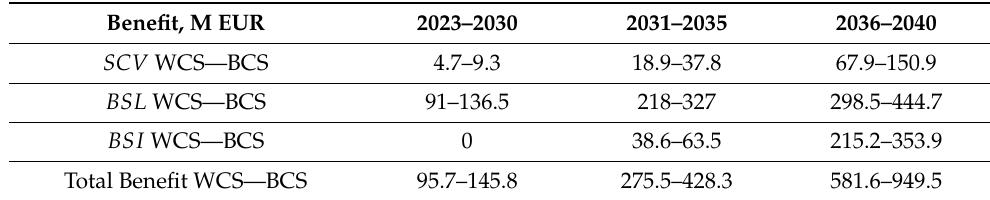
Table 7. Benefit analysis